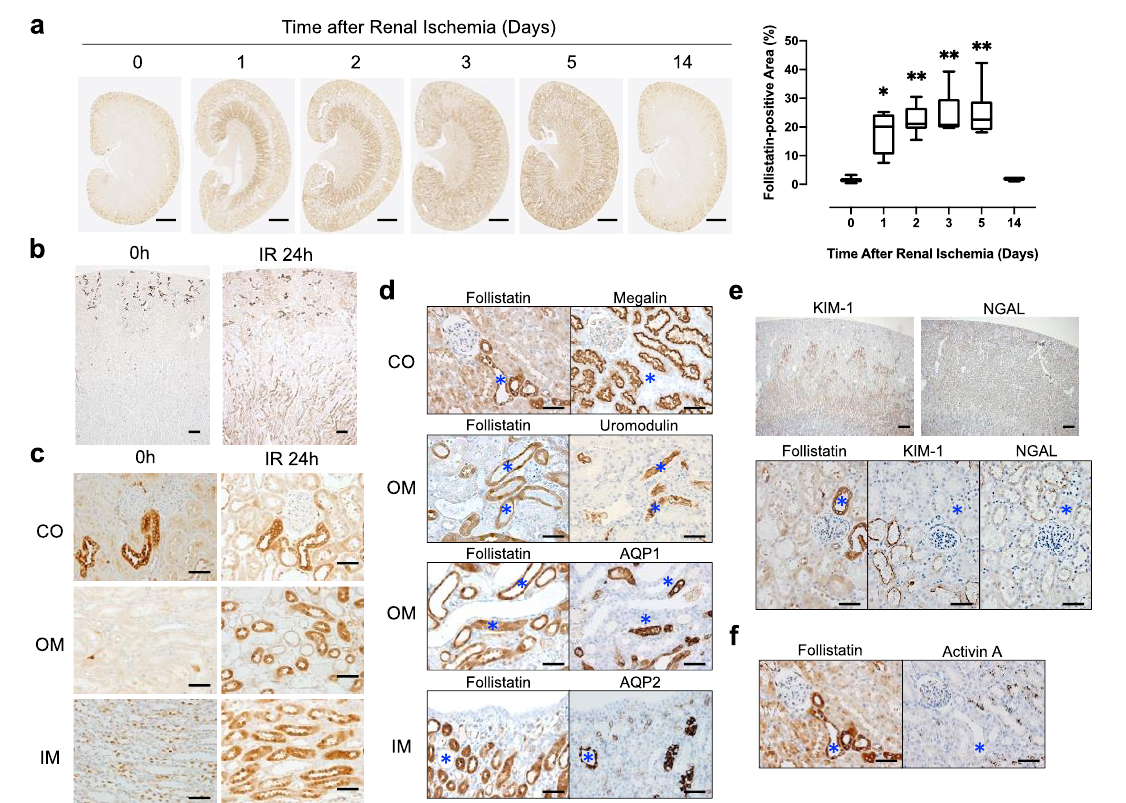
Figure 2. Localization of the follistatin protein in kidneys after renal ischemia. ( a ) Localization of follistatin (brown) in kidneys after renal ischemia was examined by immunostaining (left panel). Bar = 2 mm. Quantitative analysis of follistatin-positive area (right panel). Five randomly selected fields of the kidney were assessed at × 100 magnification. The follistatin-positive area was measured by ImageJ. Values are the means ± S.E. ( n = 6–8). * p < 0.05, ** p < 0.01 vs. 0 h ( b , c ) Localization of the follistatin protein in normal and ischemic kidneys. The kidneys were collected at 0 h and 24 h after reperfusion. Ischemia reperfusion, IR. Bar = 0.2 mm in ( b ), 50 µ m in ( c ). Cortex, CO; outer medulla, OM; inner medulla, IM. Bar = 50 µ m. ( d ) Localization of follistatin protein and megalin, aquaporin 1 (AQP1), uromodulin (UMOD), or aquaporin 2 (AQP2) in ischemic kidneys was evaluated using serial sections. Cortex, CO; outer medulla, OM; inner medulla, IM. Bar = 50 μm. ( e ) Localization of follistatin, neutrophil gelatinase-associated lipocalin (NGAL), and kidney injury molecule-1 (KIM-1) in ischemic kidneys was evaluated using serial sections. Bar = 0.2 mm (upper panels), 50 µ m (lower panels). ( f ) Localization of follistatin and activin A in ischemic kidneys was evaluated using serial sections. Bar = 50 μm. Asterisks indicate identical tubules.